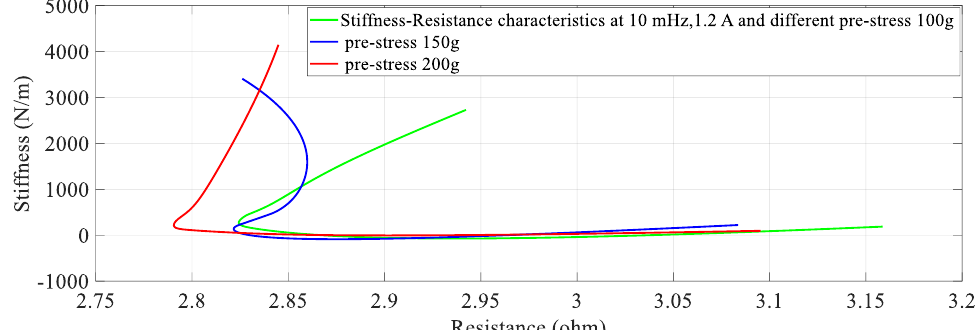
Figure 14. Stiffness response at different Pre − Stress.